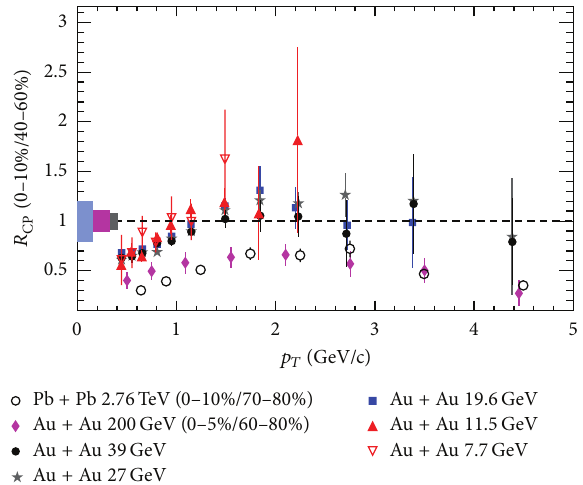
Figure5:The 𝜙 meson 𝑅 asafunctionof 𝑝 𝑇 inAu+Au[17,18]and CP Pb + Pb [21] collisions at various beam energies. Error bars are only statistical uncertainties. Bands represent normalisation error from 𝑁 which is approximately 20% for √𝑠 𝑁𝑁 = 7.7 – 39 GeV, ∼ 10% for bin 200 GeV, and ∼ 7% for 2.76 TeV.